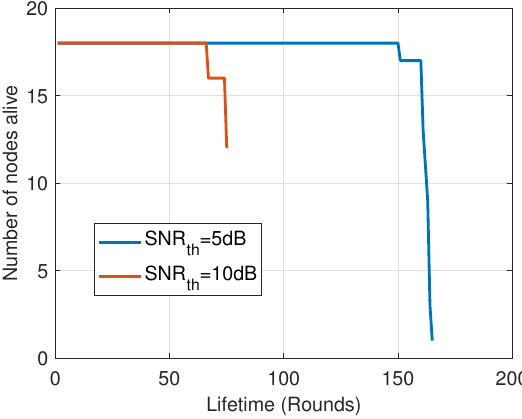
Figure 9. Lifetime versus number of nodes